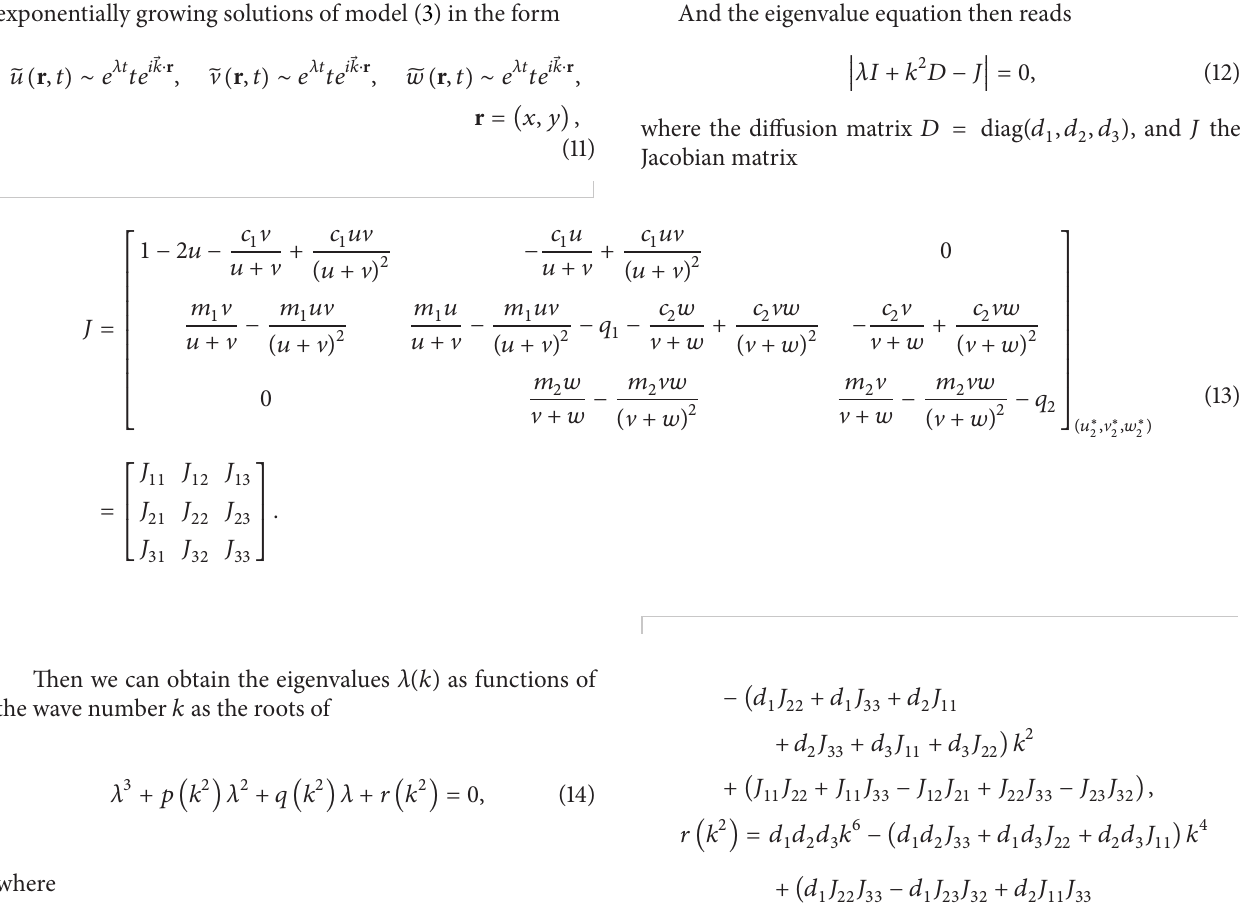
And in the presence of diffusion, set 𝑢 = 𝑢 ∗ + ̃𝑢 , V = V ∗ + ̃ V , 𝑤 = 𝑤 ∗ + ̃𝑤 , and the standard linear analysis predicts